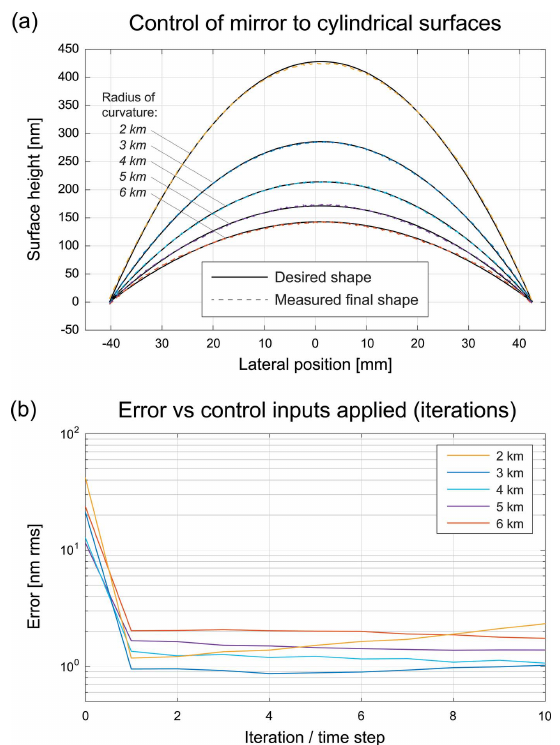
Figure 5 Controlling the mirror to cylindrical surface shapes. ( a ) Measurements of the mirror surface taken after the ten-step control algorithm is used to achieve cylindrical surface shapes. The piston was added to desired and measures surface profiles for visualization only. ( b ) Total shape error in nm RMS over ten time steps.